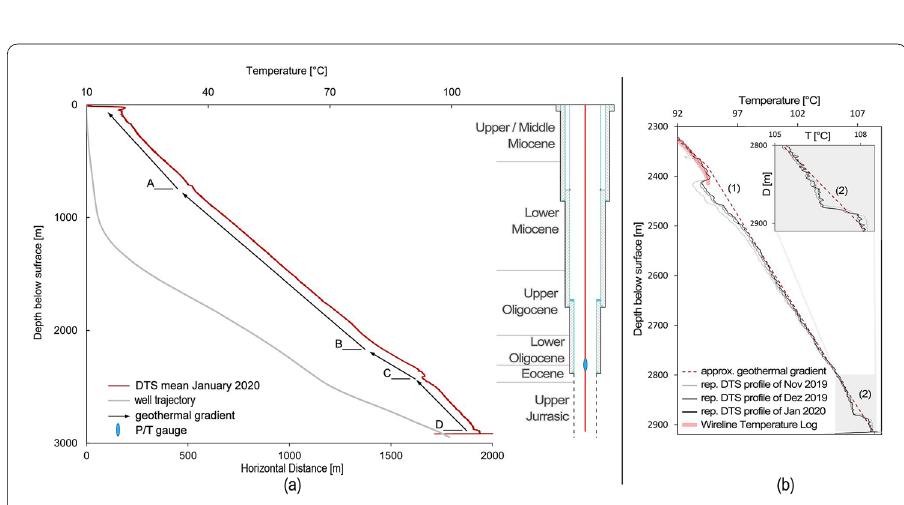
Fig. 7 Temperature gradients from DTS profile at the geothermal Schäftlarnstraße site. Subplot a shows estimated temperature gradients with vertically projected well trajectory and stratigraphy. Subplot b shows representative (rep.) DTS profiles from November 2019 to January 2020 averaged at over 6 h and with a moving average of 2 m with the wireline temperature log and the approximate thermal gradient inside the reservoir. (1) and (2) mark zones where the DTS temperature deviates from the proposed